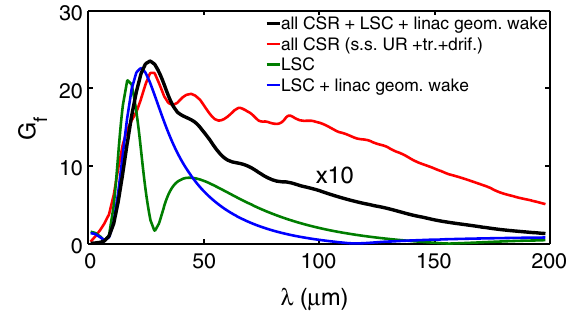
FIG. 10. Microbunching gain spectra with various combina- tions of collective effects. To simulate the gain with linac geometric impedance, here we assume the linac parameters are a ¼ 3 . 07 cm, L ¼ 10 . 0 cm, g ¼ 8 . 0 cm, and α ¼ 0 . 528 . For better illustration, the gain values with the case of all collective effects included (black curve) are presented with × 10 smaller than the calculated